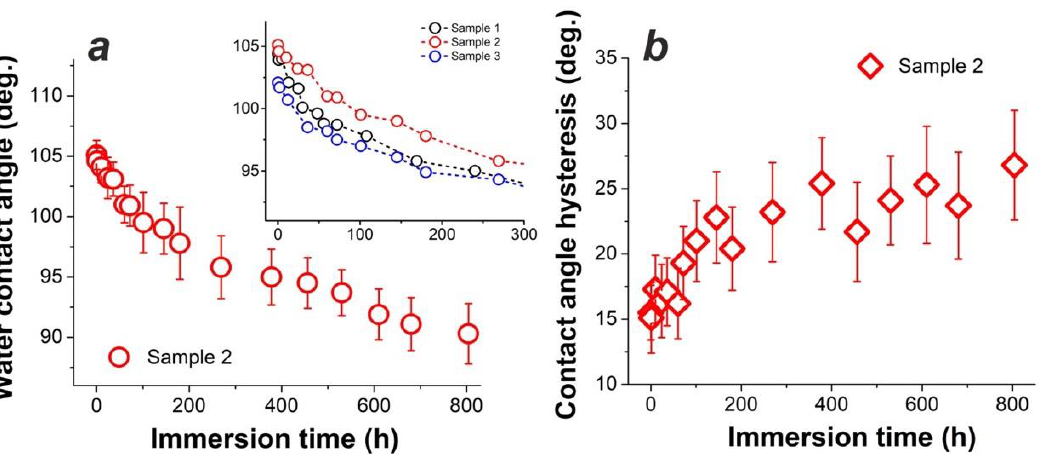
Figure 4. Wettability of sample 2 immersed in DI water for a long time. ( a ) Water CA values measured during immersion for more than 800 h. ( b ) Water CAH values measured for the same sample over time. Inset in panel ( a ) compares samples 1, 2, and 3 as their CA values are plotted vs. immersion time.